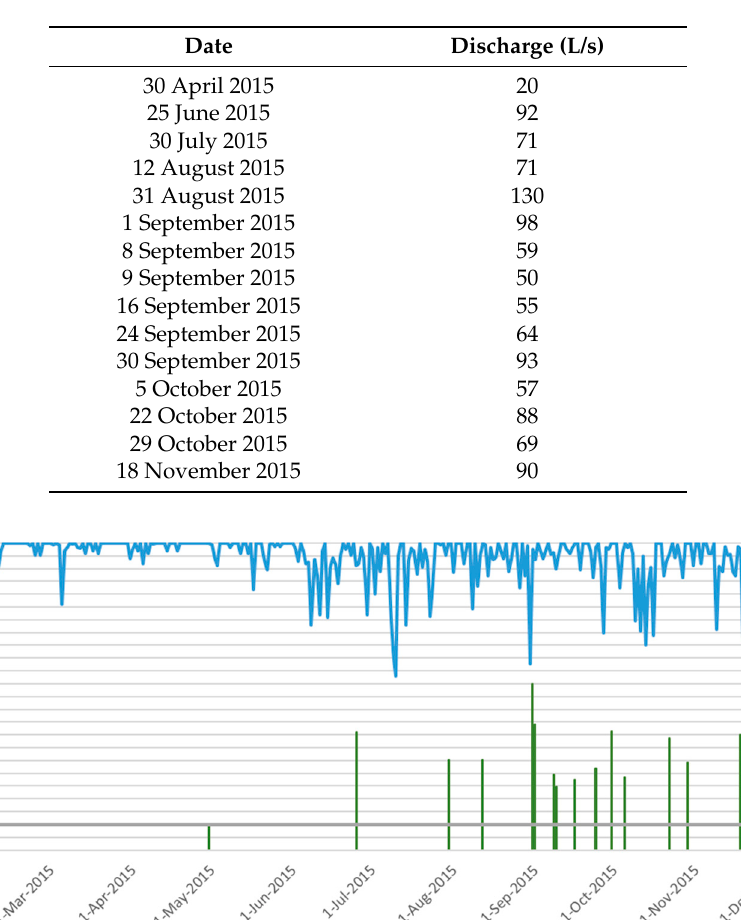
Table 1. Discharge measurements 2015.